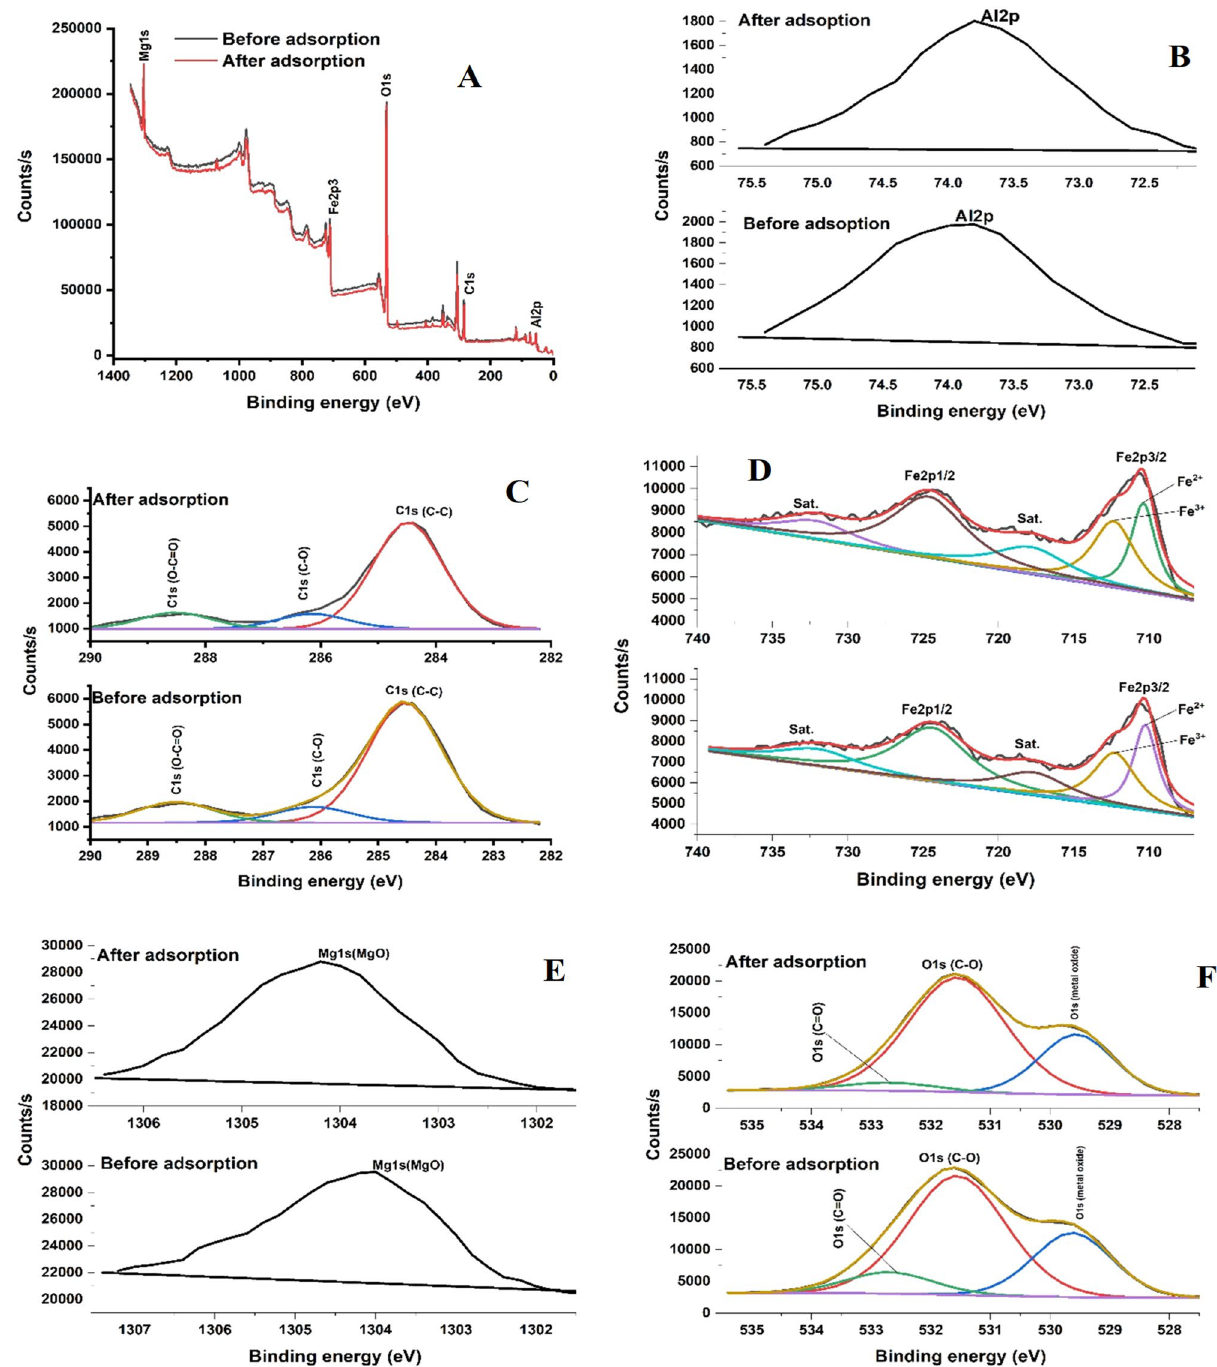
Figure 10. ( a – f ) XPS of Fe 3 O 4 @Al–Mg LDH after